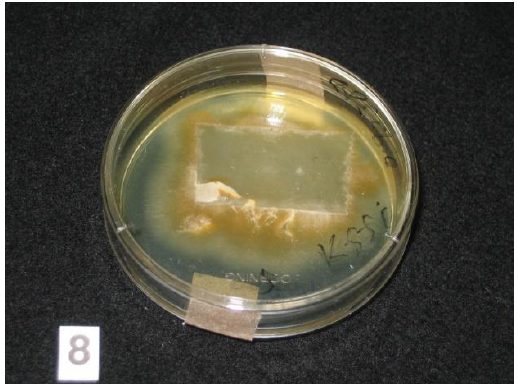
Figure 2. Adhesive tape sample containing scales and hair placed on Sabouraud dextrose agar plate. Growth of colonies of dermatophyte was seen from the edges of the tape at Week 3.